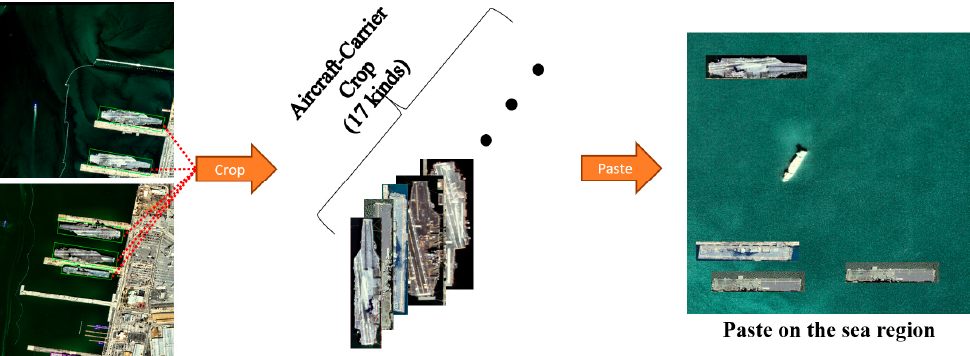
Figure 9. Aircraft carrier data augmentation using crop-and-paste in the sea region.